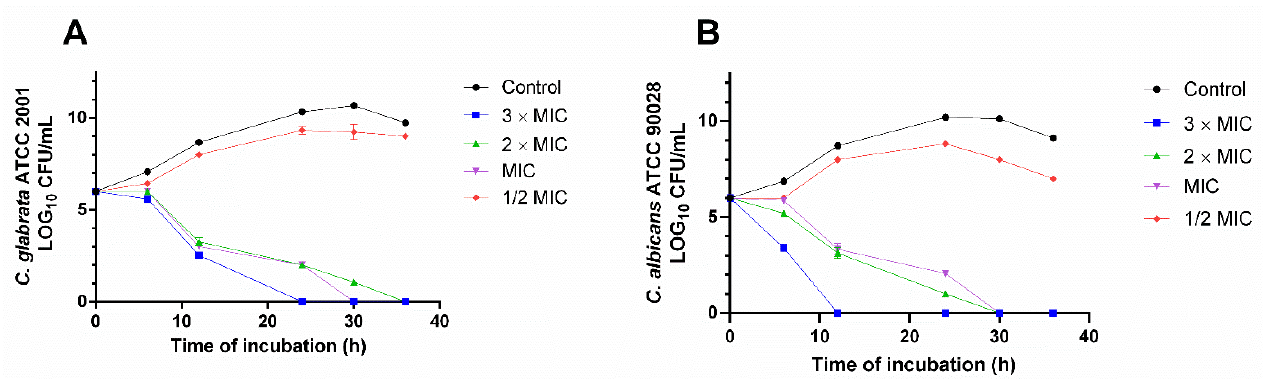
Figure 4. Time–kill curve for C. glabrata ATCC 2001 ( A ) and C. albicans ATCC 90028 ( B ). G-HHDP- G compound was tested at 3 × MIC. MIC: minimal inhibitory concentration. CFU: colony-forming unit. Time is expressed in hours. Negative control: no compound was added to the cell suspension.